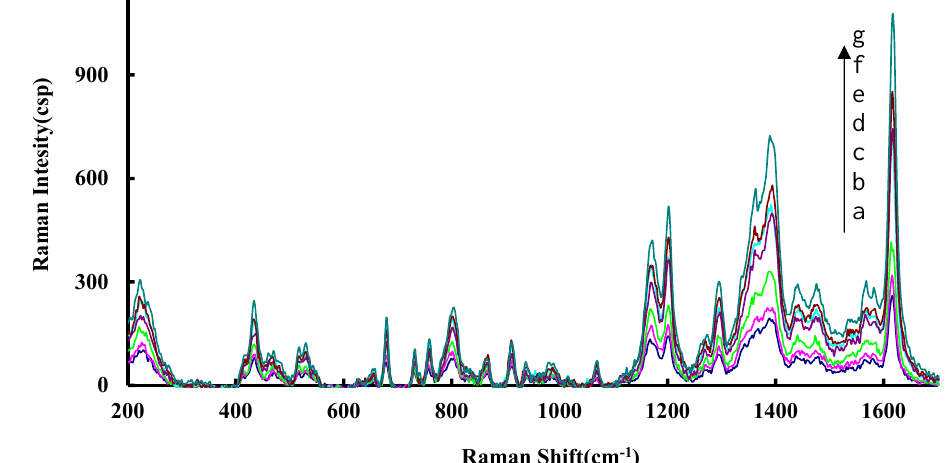
Figure 2. SERS spectrum of HAuCl 4 -H 2 O 2 -CD 1N -Na 2 SO 4 -BaCl 2 -VB4R system. ( a ): 4.2 µ mol/L HAuCl 4 + 2.5 mol/L H 2 O 2 + 5 μ g/mL CD 1N + 53 μ mol/L BaCl 2 + 0.33 μ mol/L VB4R; ( b ): a + 0.05 μ mol/L Na 2 SO 4 ;